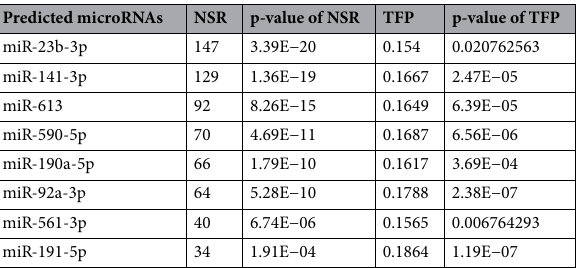
Table 1. The prediction values for 8 predicted candidate miRNA biomarkers for early detection of